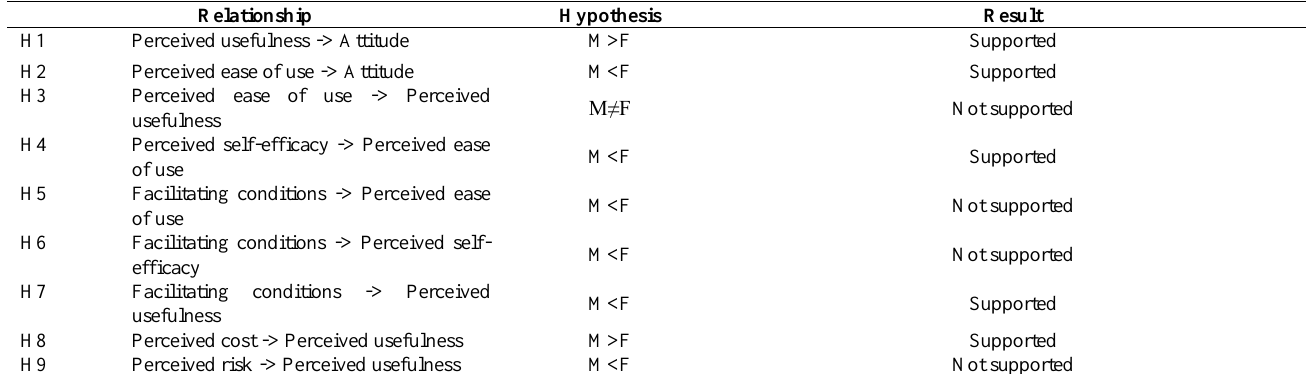
Table 7: Summary of testing results